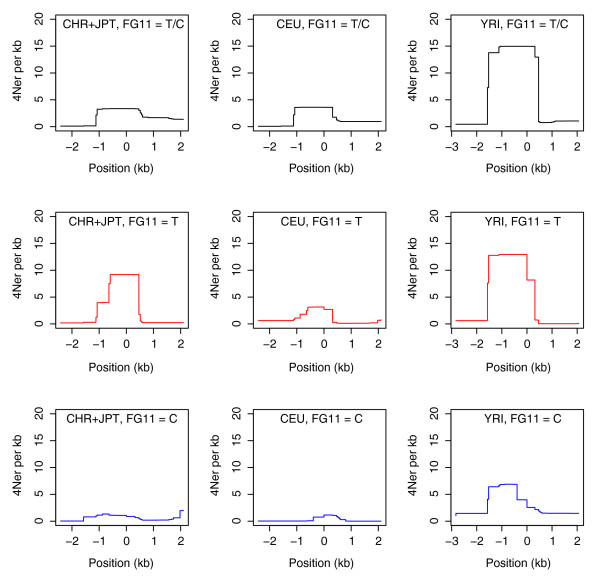
Profiles of recombination rate at the DNA2 hotspot in the MHC region in chromosome 6 of the three populations (HapMap phase II). For simplicity, we set the position of FG11 SNP at 0. The DNA2 hotspot spans from about -1 kb to 0.5 kb. In each population, the top profile is from the whole sample (T or C allele at FG11); the middle profile is from the subpopulation with the T allele (hot); the bottom profile is from the subpopulation with the C allele (cold). The population and the alleles at FG11 are labeled above each plot.